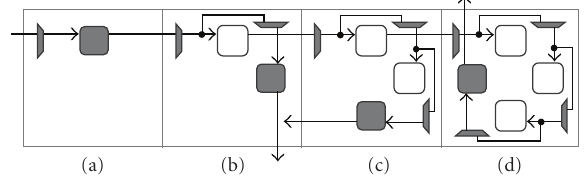
Figure 5: Using selectors to make turns of (a) 0 degrees, (b) 90 degrees, (c) 180 degrees, and (d) 270